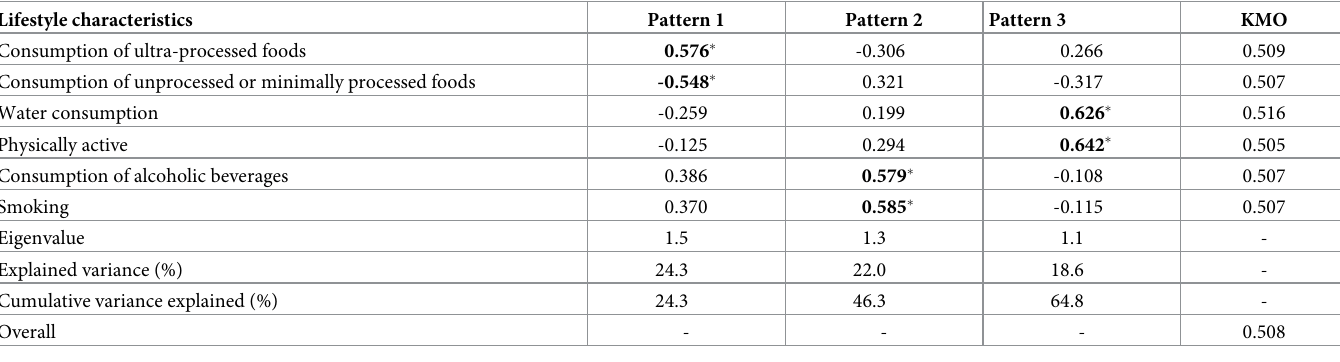
Table 2. Factor loading of principal component analysis (PCA) in Brazilian adolescents. Study of Cardiovascular Risks in Adolescents (ERICA), Brazil, 2013–2014. Lifestyle